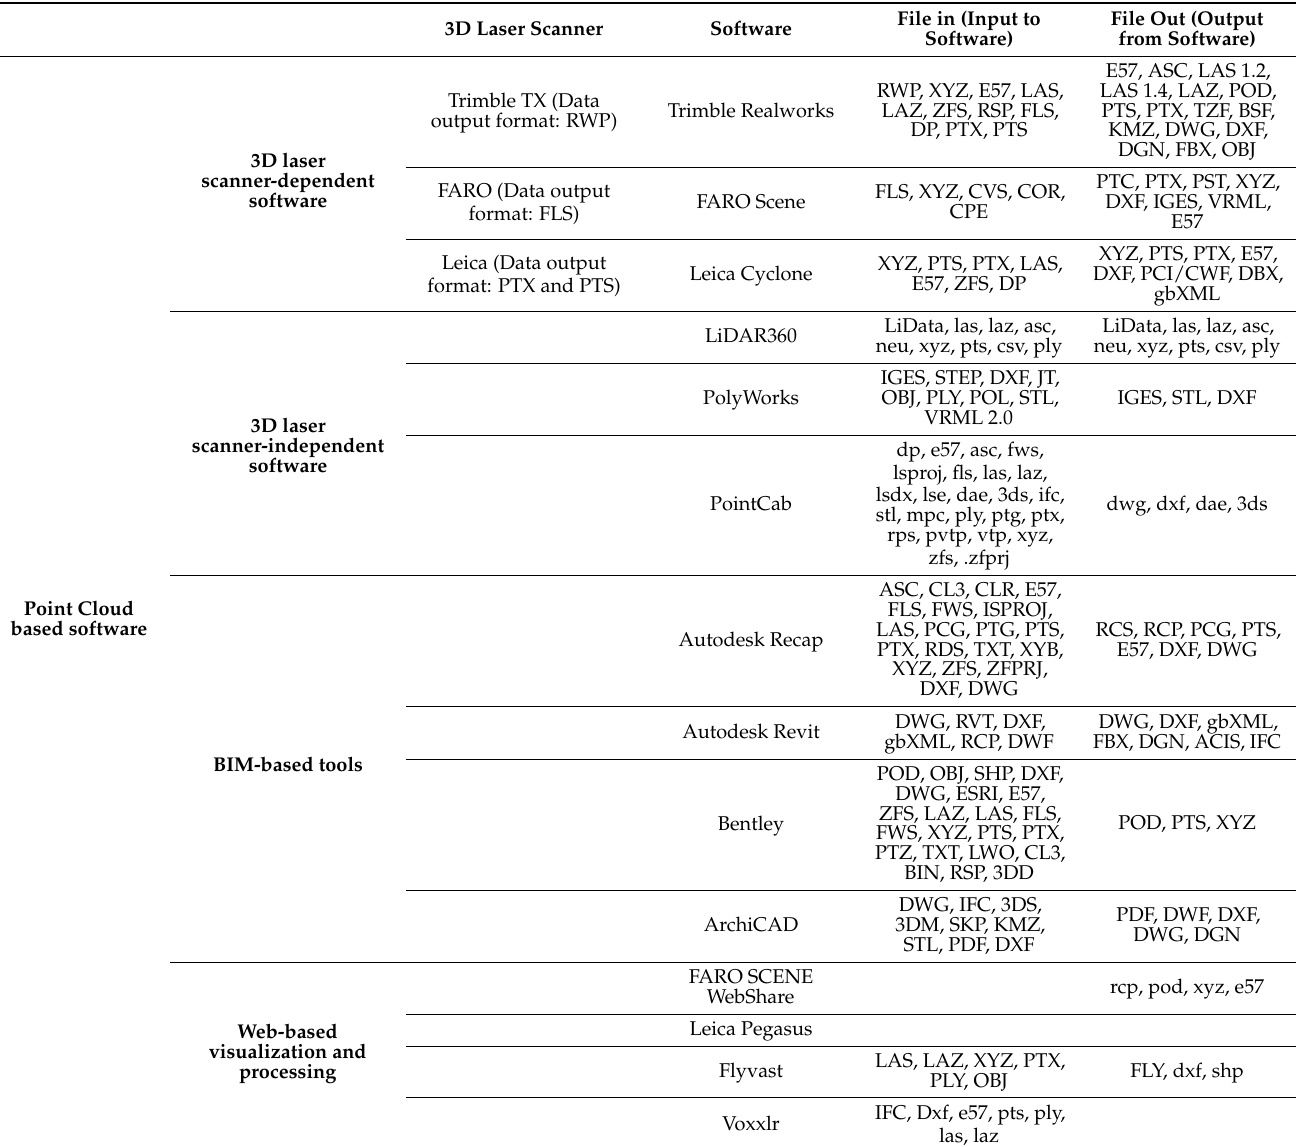
Table 8. Interoperable File Formats between Different 3D Printing-related Software